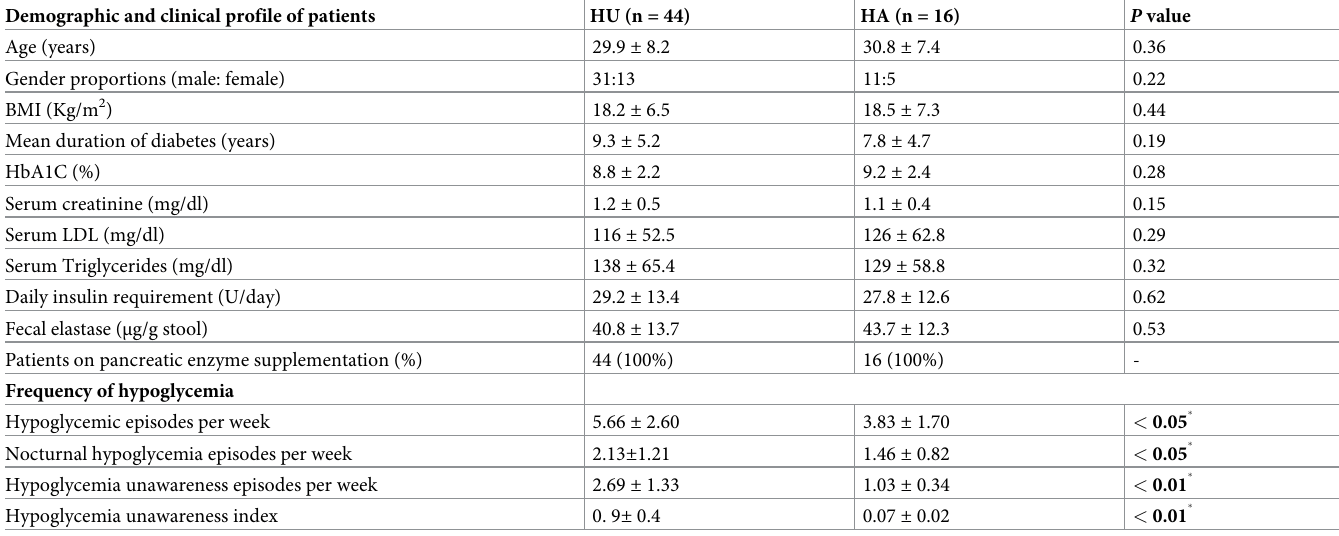
Table 1. Algorithm of the